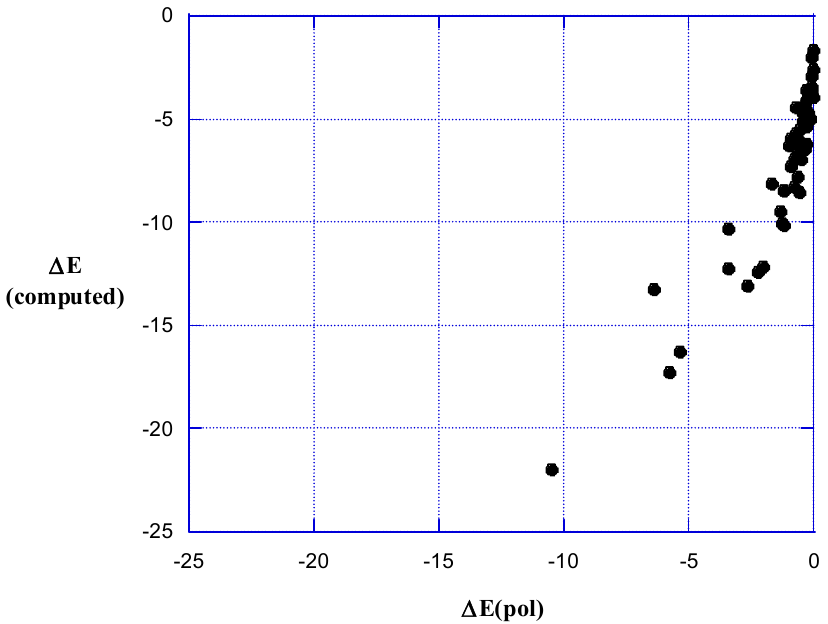
Figure 6. Computed Δ E plotted against Δ E(pol) obtained with Equation (6), in kcal/mol, for the σ -hole interactions in Table 1.